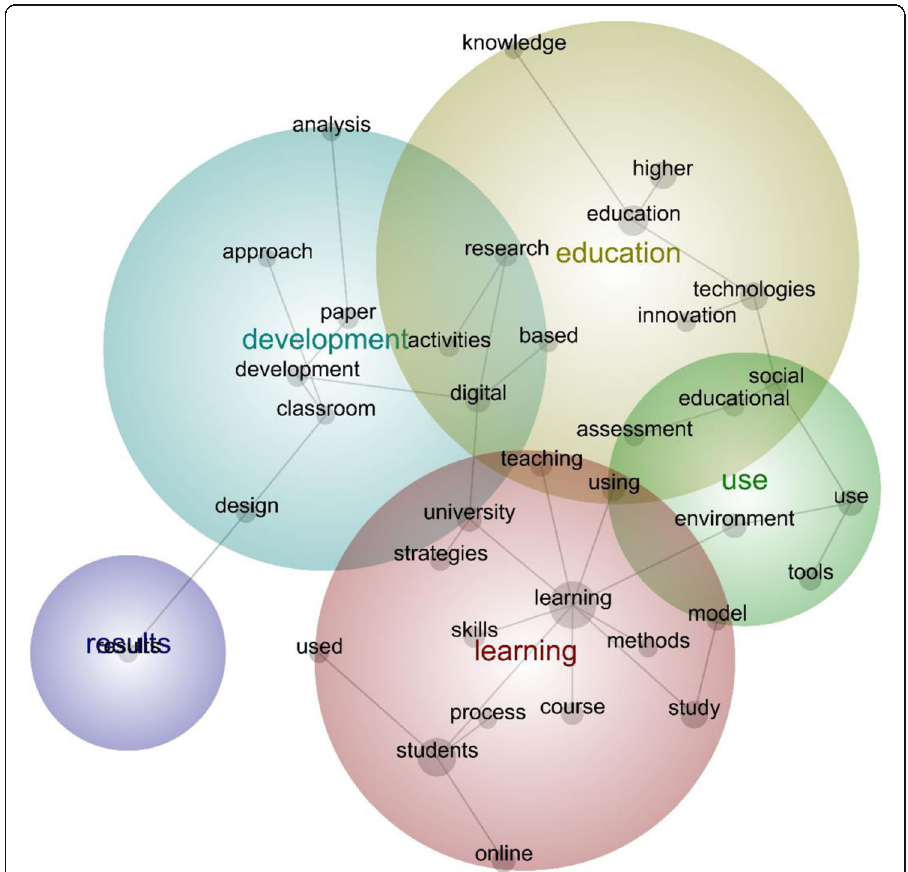
Fig. 3 Themes in the ETHE journal between 2016 and 2017 (only English articles) ( n = 64). Note: this period contains the half the number of articles of previous